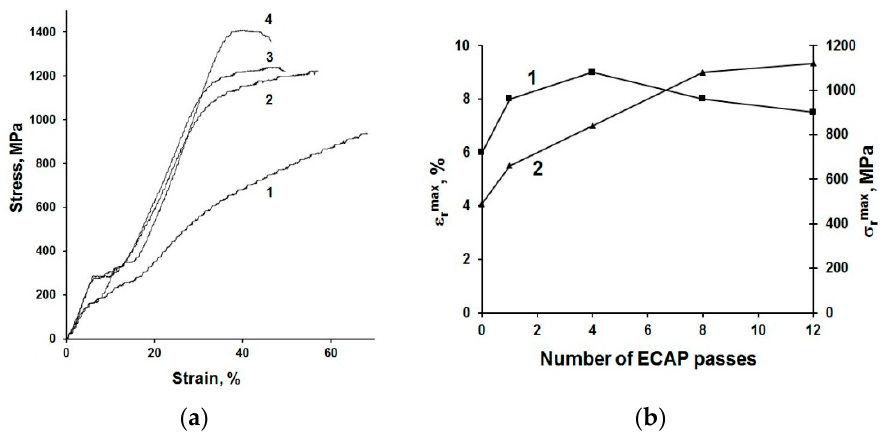
Figure 6. Mechanical properties of NiTi alloy in CG condition and after ECAP. ( a ) Engineering stress–strain curves for tensile tests in CG state (1) and after ECAP using 4 (2), 8 (3) and 12 (4) passes and ( b ) functional properties ( ε rmax and σ rmax ) as a function of number of ECAP passes [61].